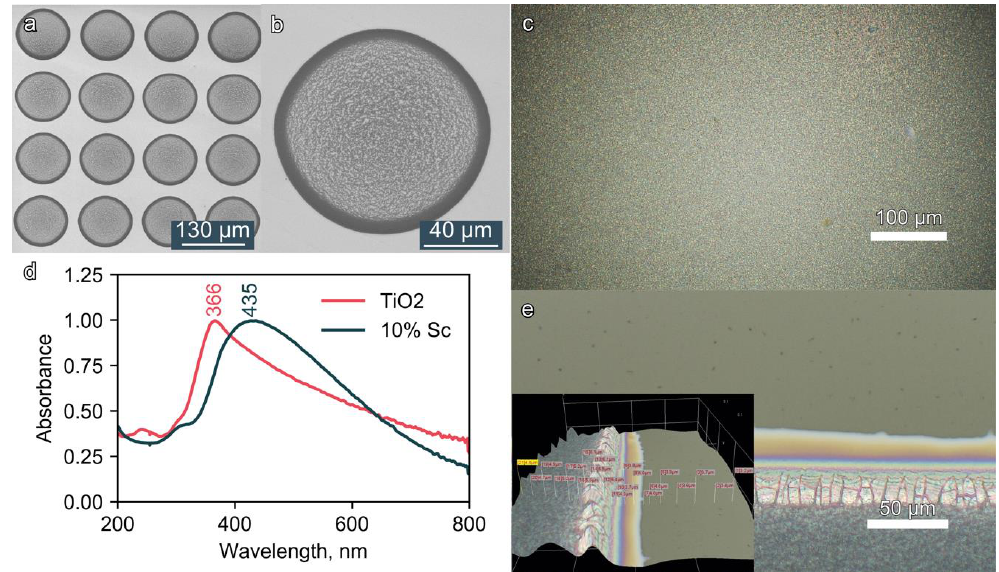
SEM images of a printed drop array ( a ) and single drop ( b ) of Sc-doped titania; optical microscope images of the central part ( c ) and edge ( e ) of the printed film (inset—film profile); optical absorbance spectra of the printed films of pure and 10% Sc-doped titania ( d ).